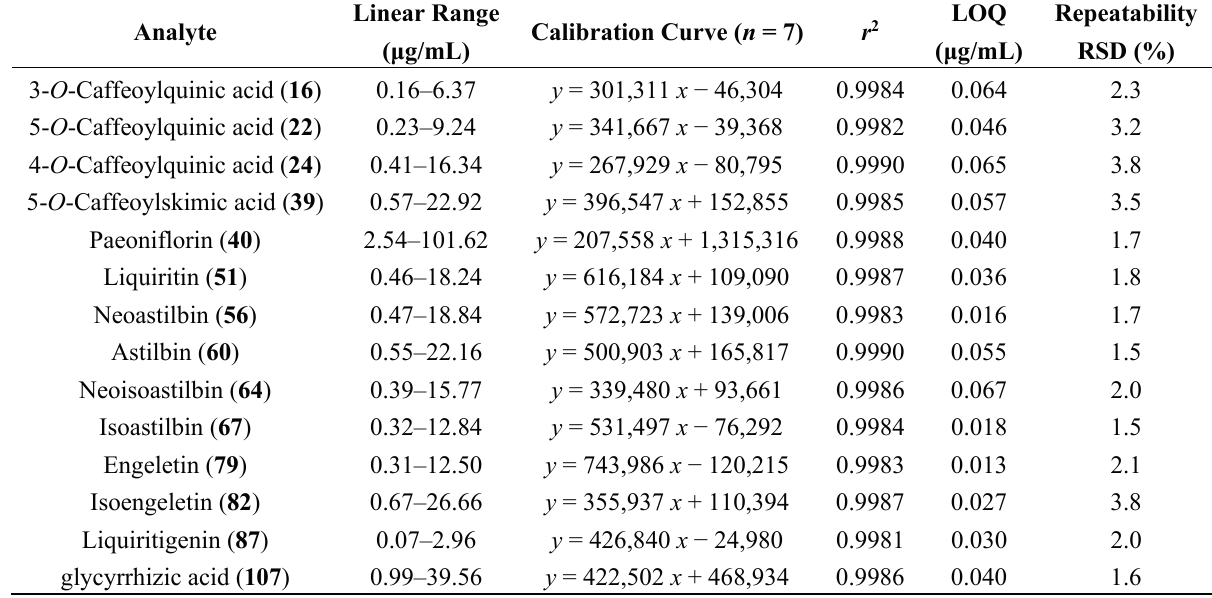
Table 2. Calibration curves, linear range, LOQ and repeatability for fourteen compounds analyzed with the UHPLC-MS system.